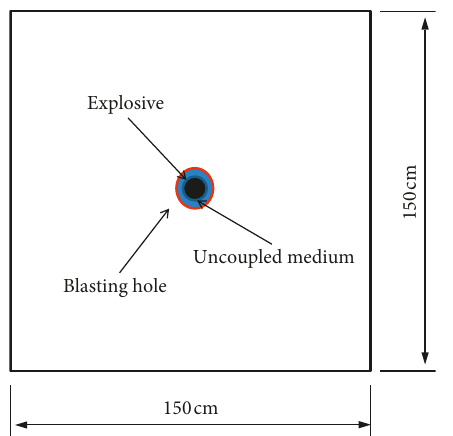
Figure 15: Comparison test of different uncoupling media.